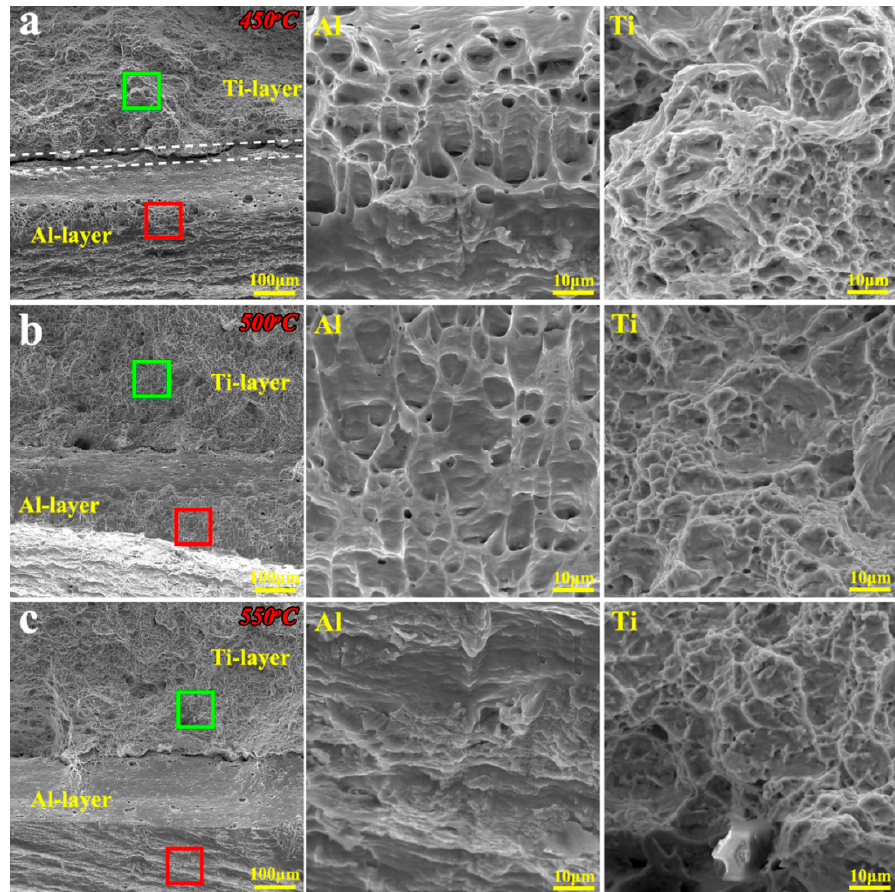
Figure 8. Fracture morphologies of hot-rolled Al/Ti LMCs at different diffusion temperatures: ( a ) 450 °C, ( b ) 500 °C and ( c ) 550 °C. Right images are the magnification of selected zone in left images observed in Al and Ti layers, respectively.